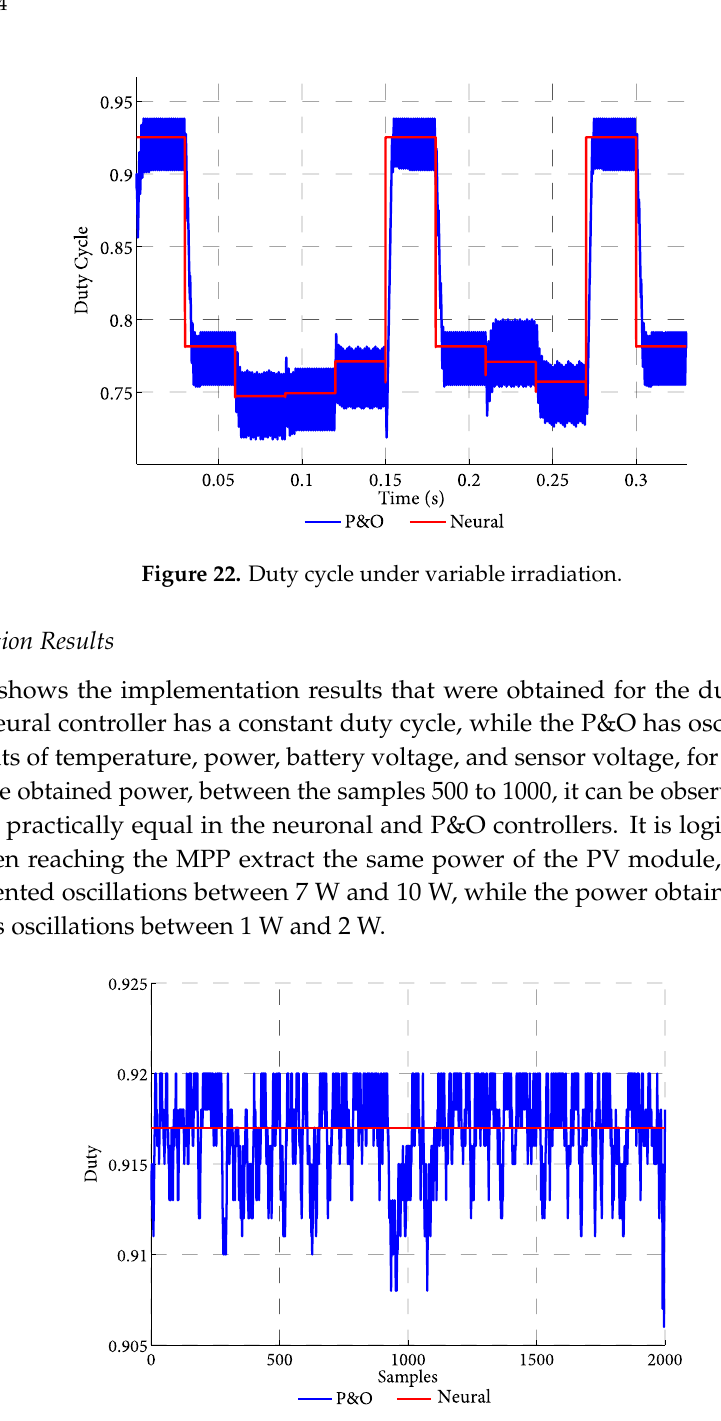
Figure 21. Output power of the PV module under variable irradiation.